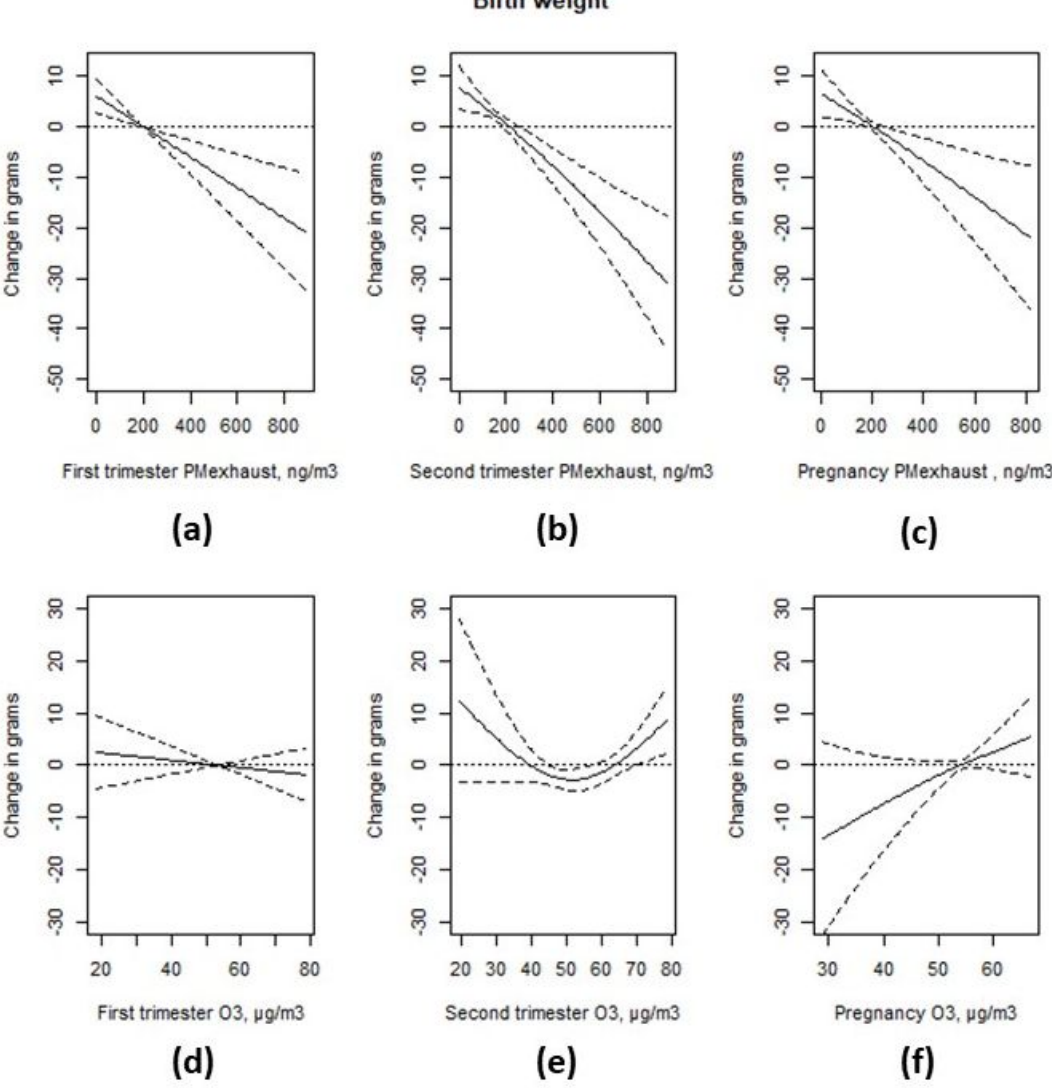
Figure 4. Associations between PM-exhaust (a–c), ozone (O 3 ) (d–f) during different stages of gestation and birth weight from two-pollutant models. All models were adjusted for maternal and paternal level of education, family income, area level income and education, family situation, parity, maternal smoking habits, body mass index (BMI) at first antenatal visit, maternal region of origin, maternal age at delivery, duration of gestation, and conception date.